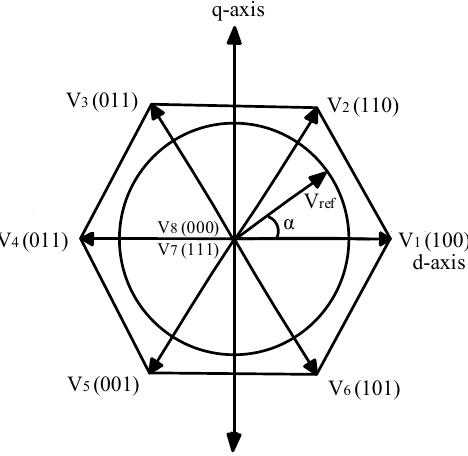
Figure 4. Vector representation of the SVPWM signal .